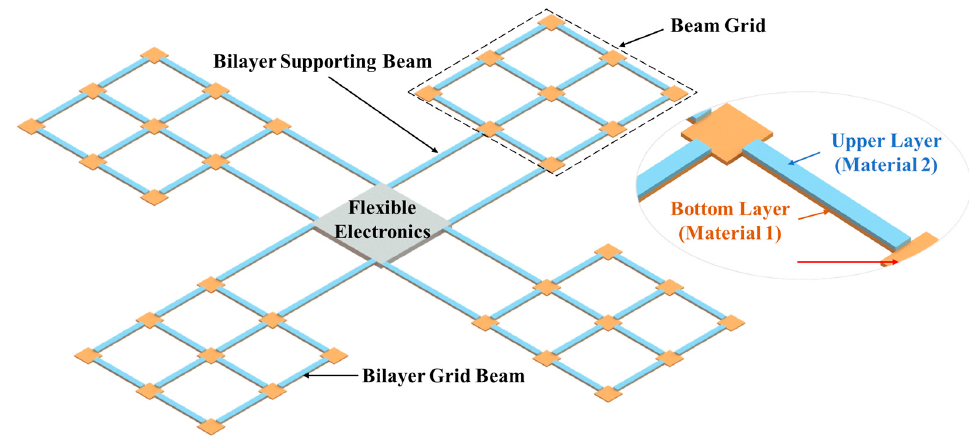
Figure 1. Conceptual design of the microrobotic ChipSail system for solar sailing (not to scale). Generally, the complete ChipSail system herein is composed of a fl exible electronics- based satellite body and four microrobotic solar sails capable of active recon fi guration.